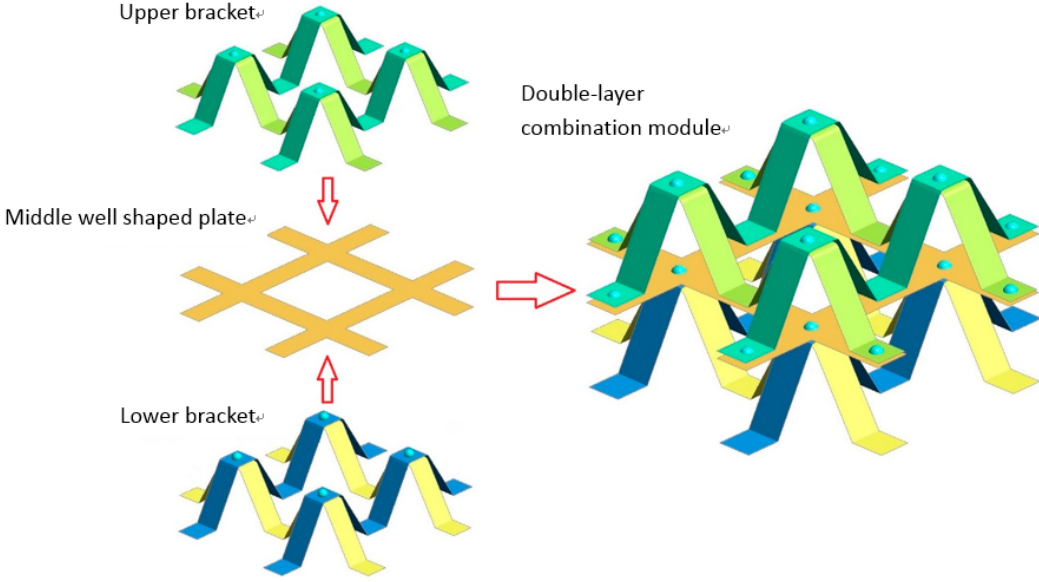
Figure 11. Schematic diagram of interlayer relationship of double-layer composite module.